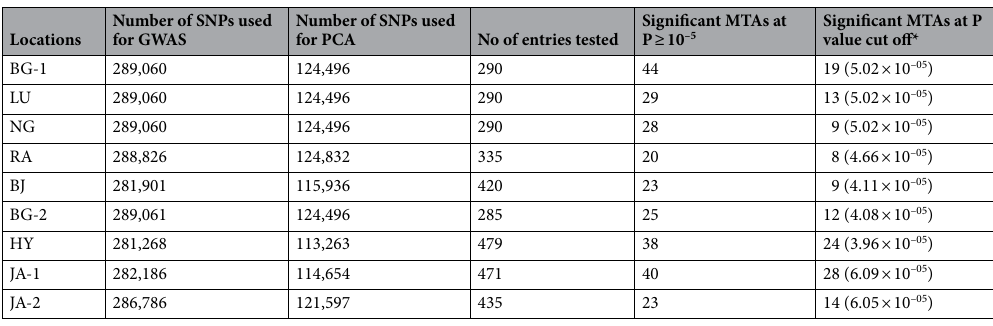
Table 3. Number of SNPs used for GWAS and PCA analysis and numbers of marker-trait associations (MTA) for grain yield under heat stress at individual